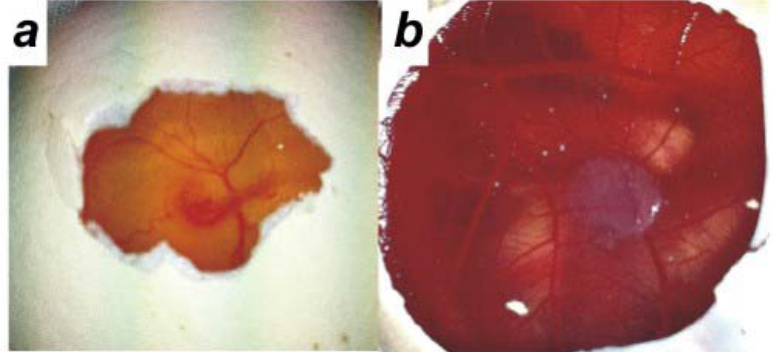
Figure 2. ( a ) Day 3 chick embryo; ( b ) Ovarian cancer cells and matrigel graft on the chick chorioallantoic membrane (CAM) on day